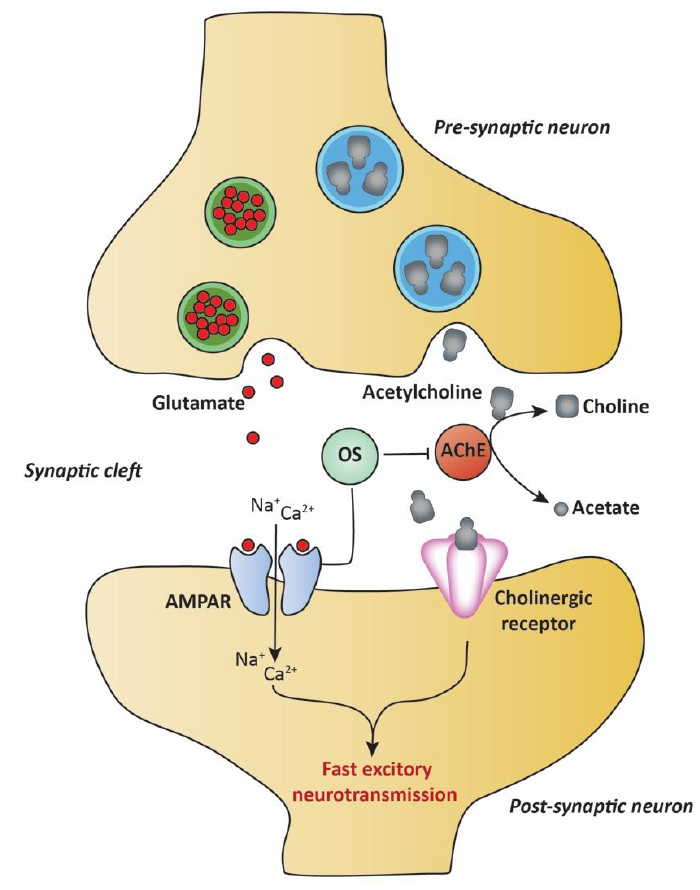
Figure 5. Origanum syriacum exhibits neuroprotective activities on fast excitatory neurotransmission in the central nervous system. Origanum syriacum regulates the glutamatergic neurotransmission system by stabilizing the desensitized/deactivated conformation of the glutamate receptor AMPAR, thus reducing its activity and decreasing the risk of neurotoxicity. Origanum syriacum also restores cholinergic neurotransmission by inhibiting the activity of AChE and preventing the hydrolysis of acetylcholine to choline and acetate. OS: Origanum syriacum ; AMPAR: α -amino-3-hydroxy-5-methyl-4-isoxazolepropionic acid receptor; AChE: acetylcholinesterase enzyme.